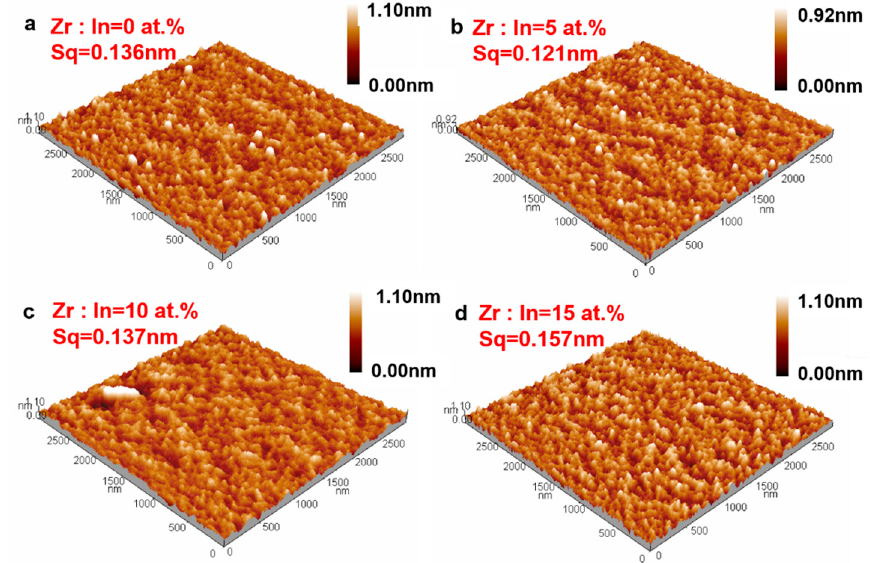
Figure 5. Atomic force microscopy (AFM) 3D images (3.0 × 3.0 μ m 2 ) of In x Zr y O thin films at 400 °C with different Zr doping concentrations, ( a – d ): Zr:In = 0, 5, 10, and 15 at.%, respectively.